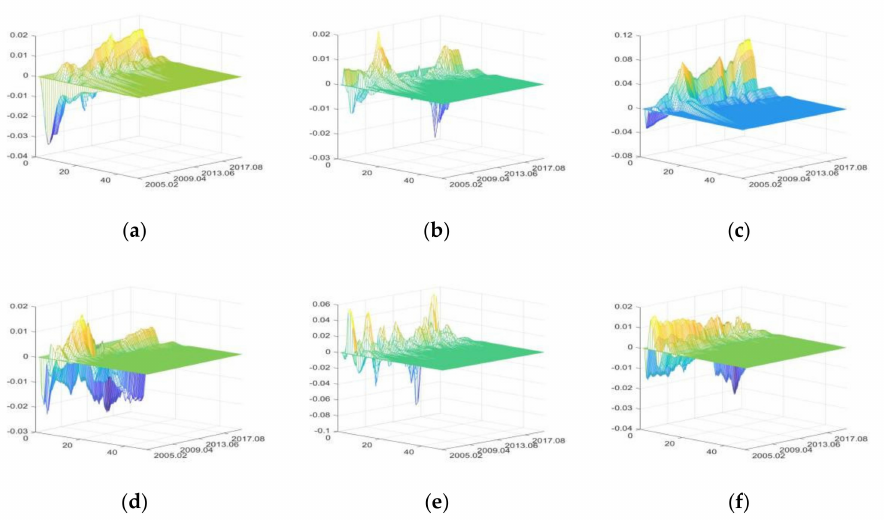
Figure 6. The three-dimensional impulse responses of PVPA to positive shocks of external uncer- tainties. ( a ) Shocks of IRU. ( b ) Shocks of FU. ( c ) Shocks of SDU. ( d ) Shocks of CU. ( e ) Shocks of DE. ( f ) Shocks of